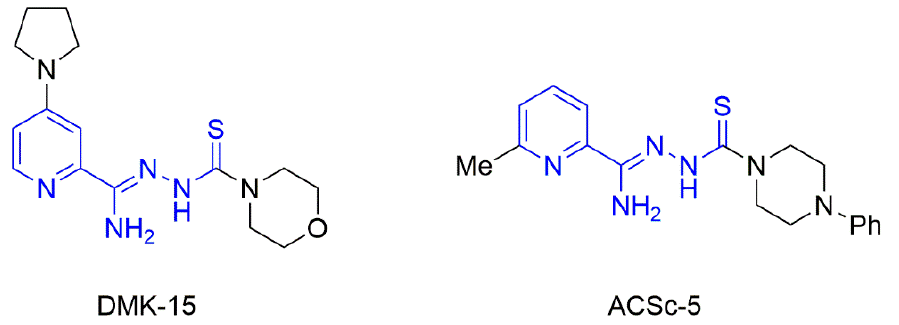
Figure 1. Structures of picolinohydrazonamide DMK-15 and ACSc-5 .